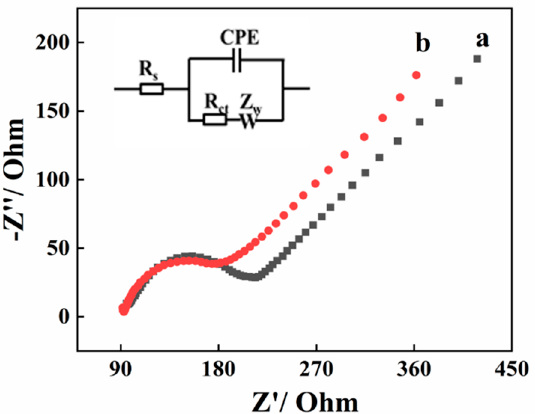
Figure 1. Nyquist plots of bare GCE (a) and AGCE (b) in 0.1 mM [Fe(CN)6] 3 − /4 − solution containing 1 M KCl. Inset: the equivalent circuit.